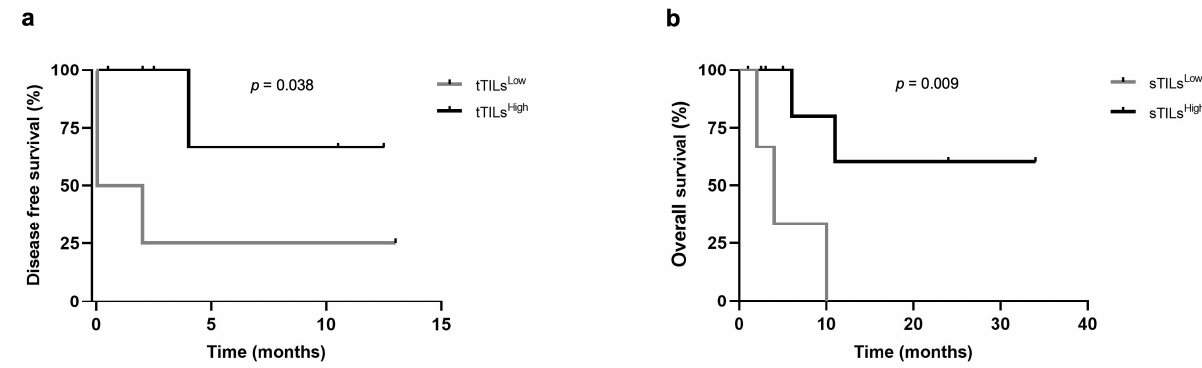
Figure 4. Disease-free survival and overall survival of cats with triple-negative mammary carcinoma according to low or high expression of TIM-3+ on total and stromal TILs. Kaplan–Meier survival curves for association of ( a ) total TIM-3+ TILs with disease-free survival and ( b ) stromal TILs with overall survival.